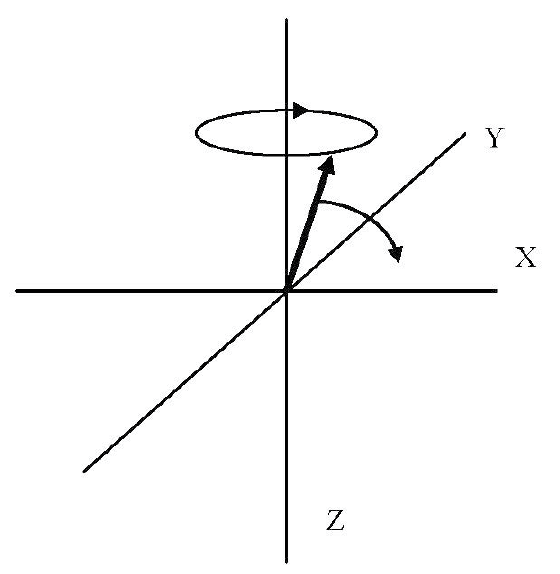
Figure 1. A schematic showing the precession of the vector (bold, thick arrow) around the z-axis. The vector tilts towards the X-Y plane when a radio frequency pulse is applied to the sample (modified from Solomons et al 33